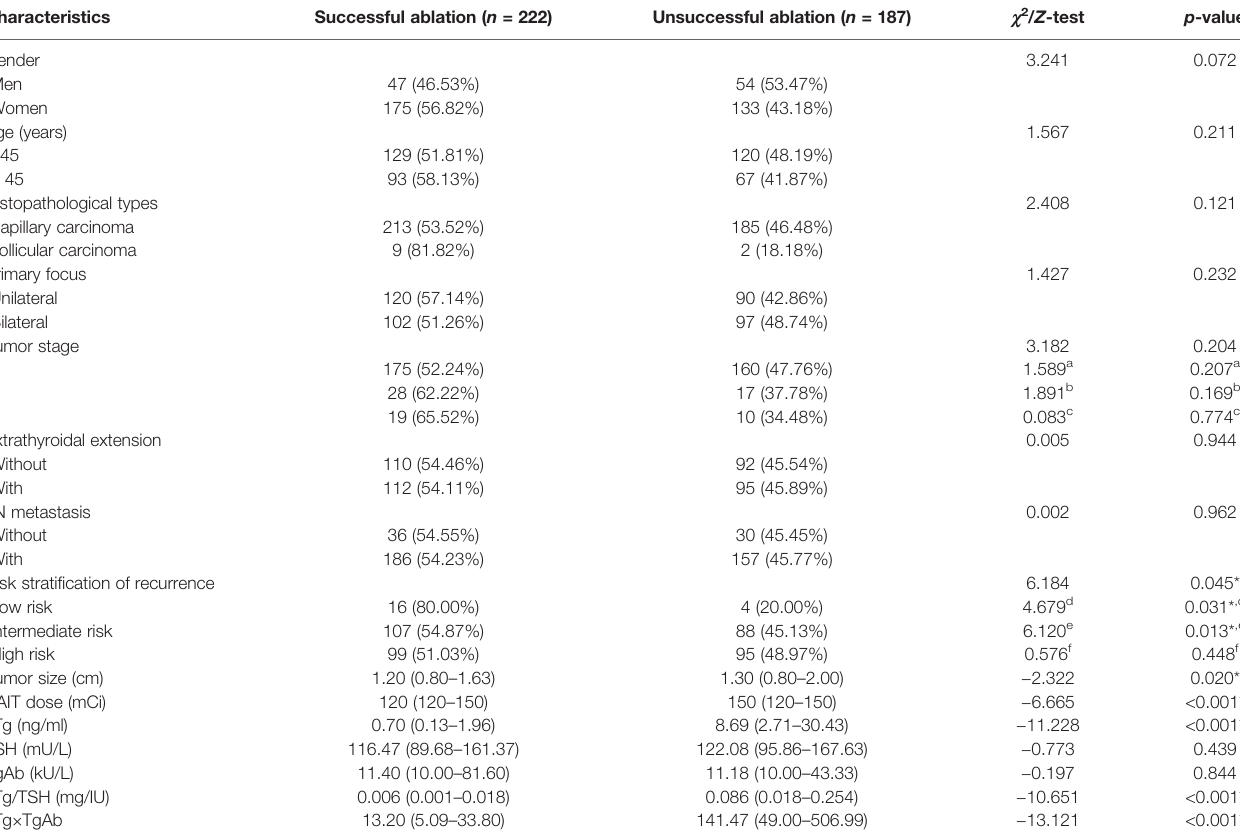
TABLE 1 | Comparison of characteristics on the ef fi cacy of the initial 131 I treatment. Characteristics